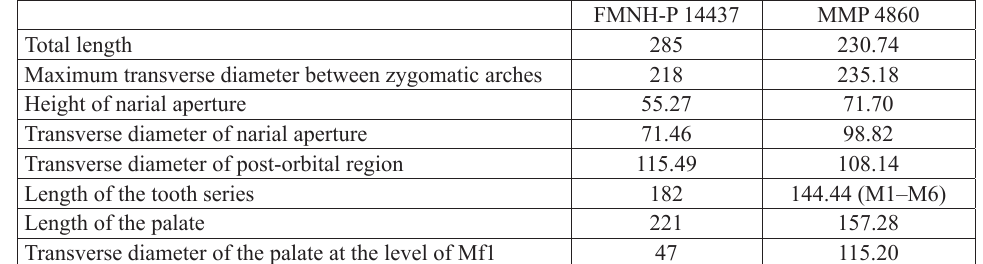
Table 1. Skull linear measurements (in mm) of Eleutherocercus solidus (FMNH-P 14437) and cf. Eleutherocercus antiquus (MMP